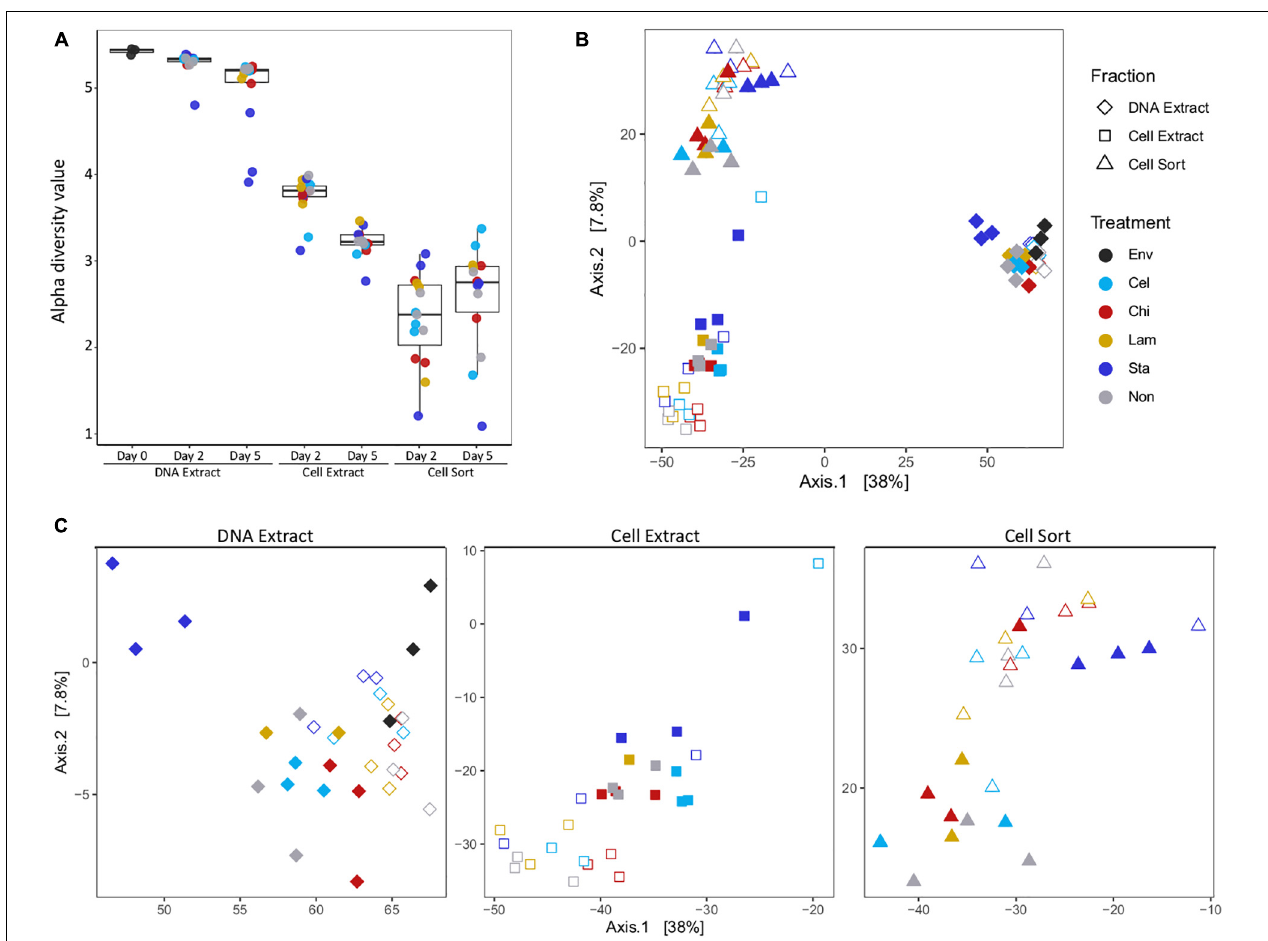
FIGURE 1 | Alpha and beta diversity. Alpha diversity (Shannon index) decreased between fractions and timepoints (A) . Principal coordinate analysis showing differences in beta diversity between samples of all fractions (B) and each fraction separately (C) . Env: environmental sample (inoculum), Cel: cellulose, Chi: chitin, Lam: laminarin, Sta: starch, Non: no amendment. For each treatment filled symbols show day 2 and open symbols day 5.